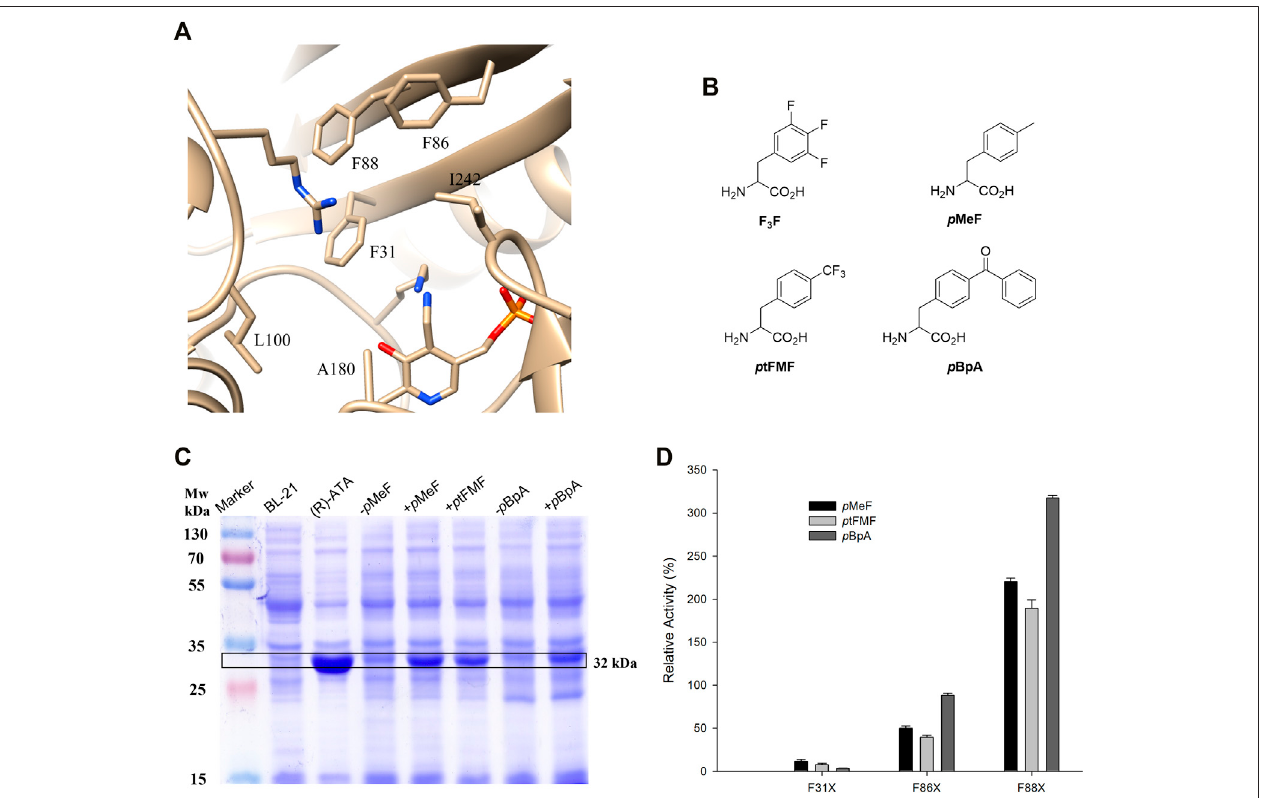
FIGURE1|(A) Active siteresidues ofrationallydesigned ( R )-ATA fromDATA scaffold. (B) Structures ofncAAsselectedforincorporationintoactive site of( R )-ATA (C) Coomassie-stainedSDS-PAGEshowingexpressionofproteinsinpresenceandabsenceofncAAs; (D) RelativeactivitiesofvariantscontainingthreeselectedncAAs at 31 st , 86 th and 88 th position. The speci fi c activity of parent ( R )-ATA (324 mU mg − 1 ) was taken as 100%.